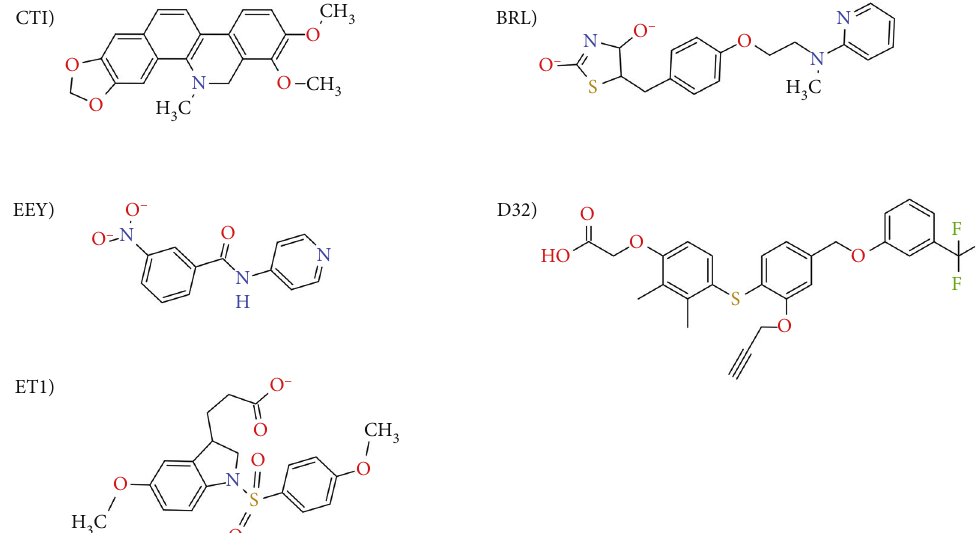
Figure 2: Chemical structure of the active molecules in the positive control group used in the molecular docking: ET1 for PPAR α , D32 for PPAR β / δ , and CTI, EEY, and BRL for PPAR γ